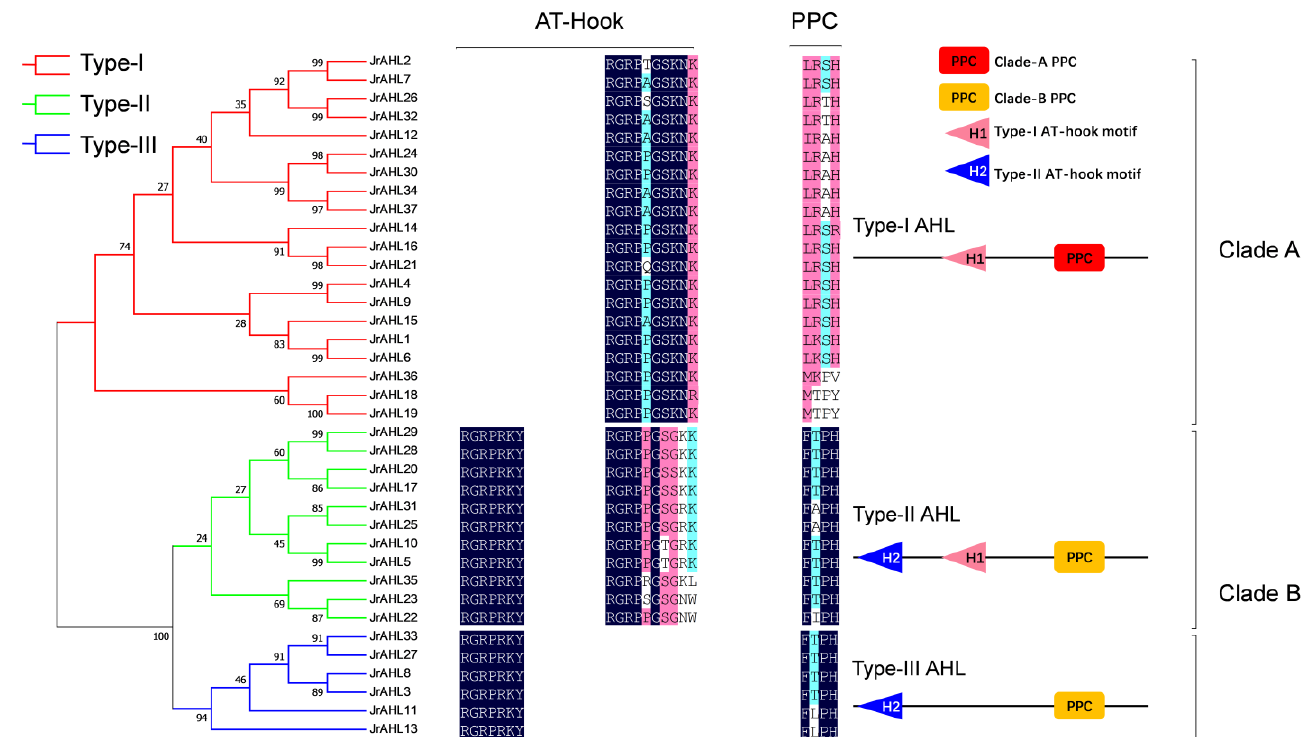
Figure 2. Phylogenetic ( left panel ) and sequence alignment ( right panel ) analysis of the walnut AHL proteins. The obtained phylogenetic tree by MEGA7 is shown on the left. Multiple sequence alignment analysis was performed using DNAMAN software, and the conserved domain is displayed on the right.